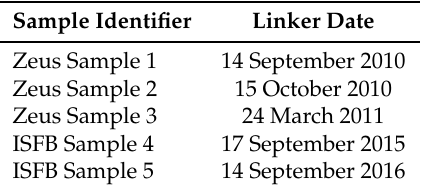
Table 3. Malware Linker Dates.